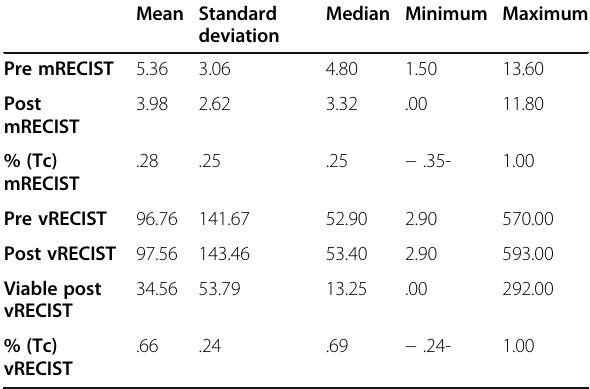
Table 2 Measurements of lesions by mRECIST & vRECIST both